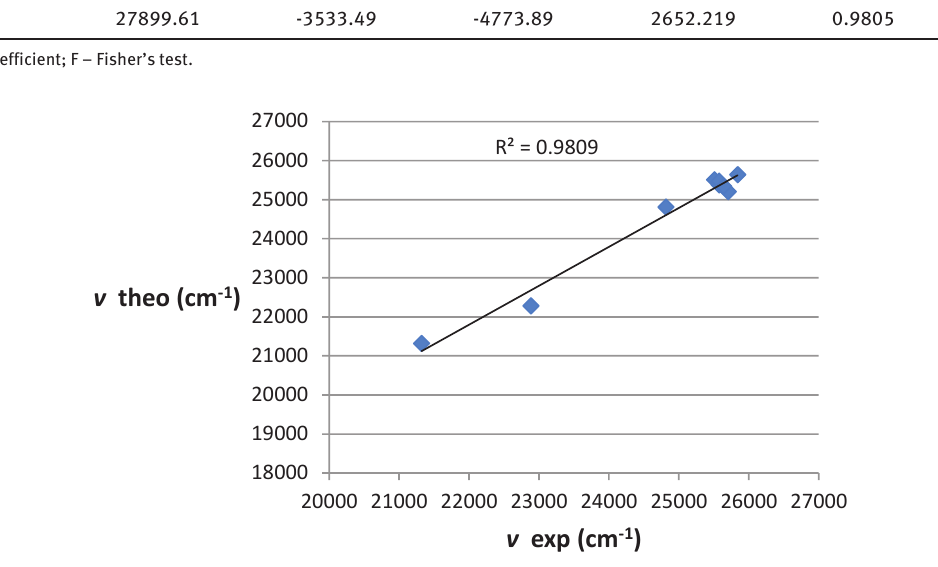
Table 4: Regression fits to solvatochromic parameters of Eq. 1 Azo compound in